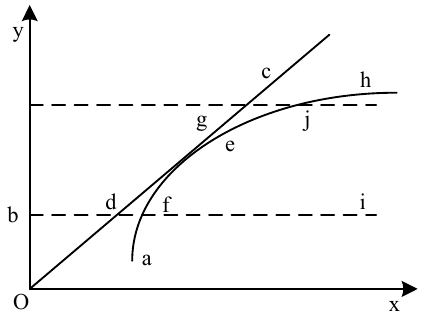
Figure 2. Pure technical efficiency and scale efficiency of enterprises.